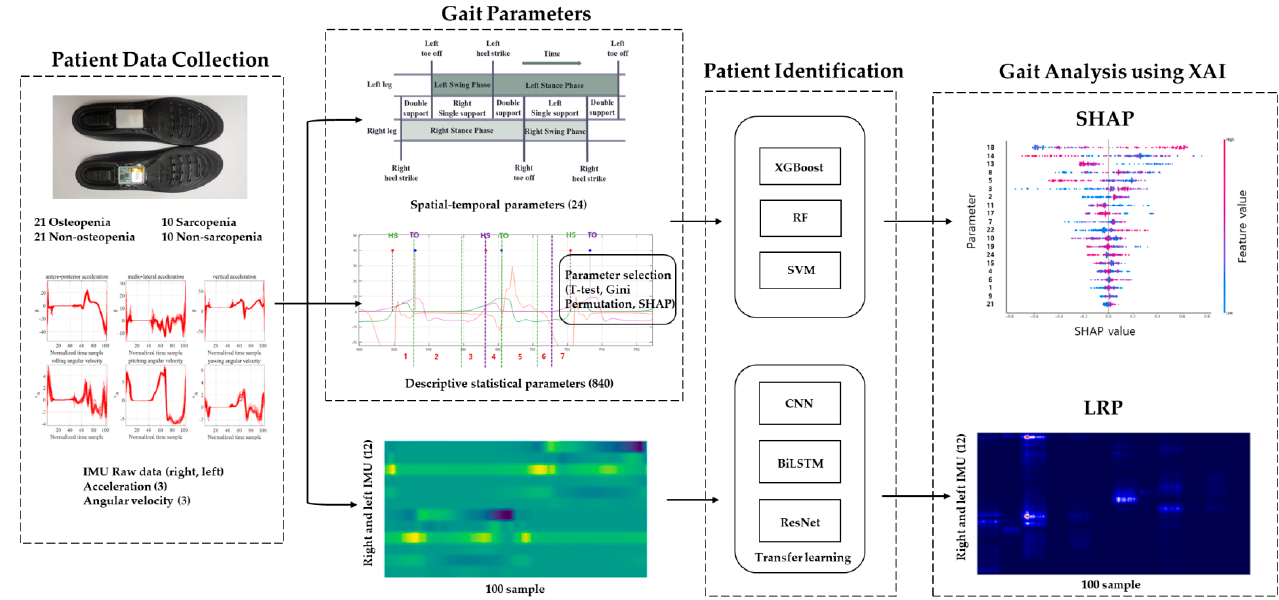
Figure 1. Gait analysis